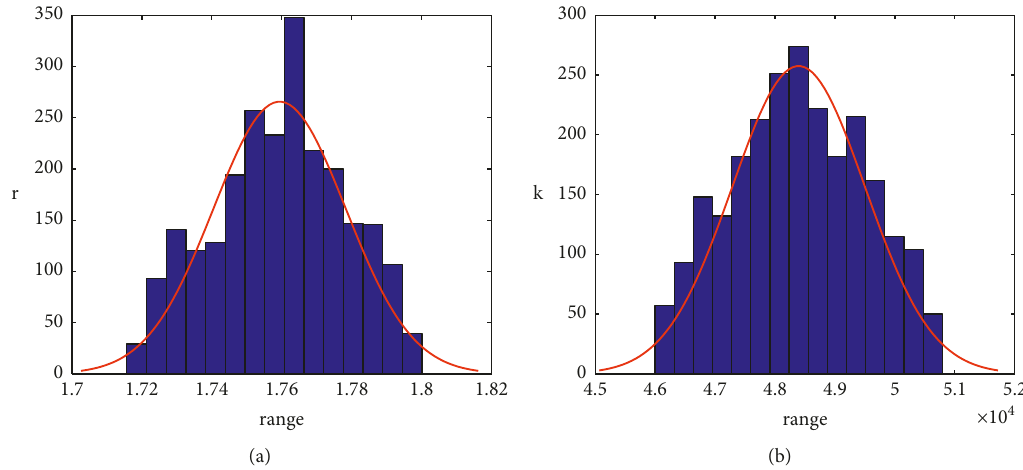
Figure 1: Parameter histograms of logistic model of the IABC-SMC algorithm. (a) Estimation of r . (b) Estimation of K . Here, the initial � 5 , a � 0 . 4 ,T � 6 , and t � 12. states are n � 6000 ,x 0 Table 3: Parameter ranges and statistics of the logistic model. Parameter Lower bound Upper